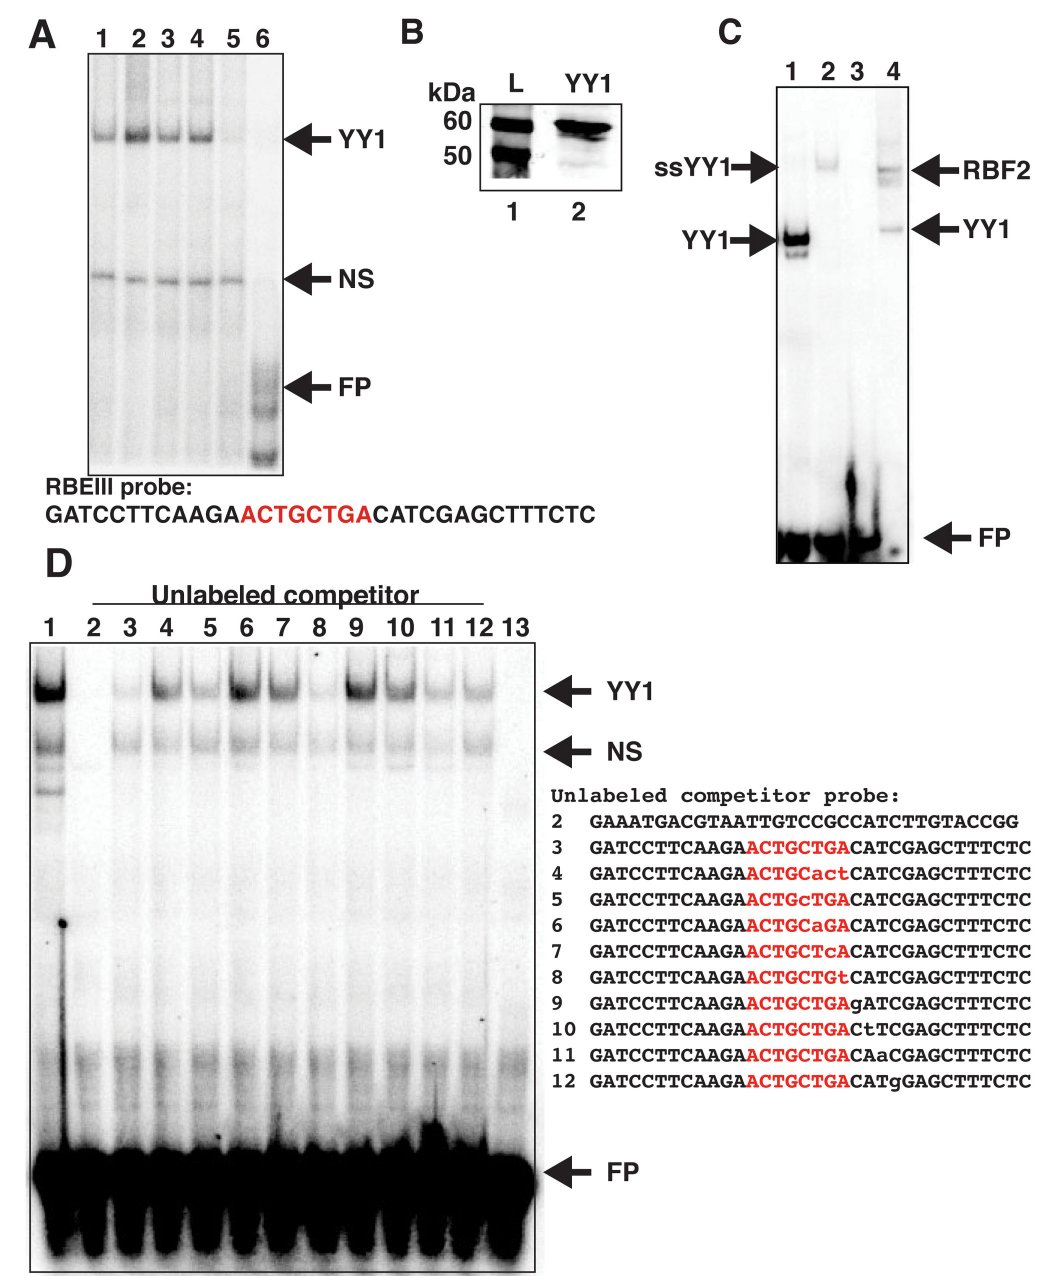
Figure 1. YY1 binds to the HIV-1 LTR near RBEIII. Panel A : EMSA was performed with Jurkat nuclear extracts and radiolabeled RBEIII probe (core RBEIII site highlighted in red). Antibodies to TFII-I (lane 2), USF1 (lane 3), USF2 (lane 4), or YY1 (lane 5) were added to analyze the complex components. Free probe (FP) is shown in lane 6. Panel B : An extract from SF9 cells infected with a baculovirus expressing YY1 was separated on 12% SDS-PAGE and analyzed by immunoblotting with YY1 antibody (lane 2). Lane 1 contains a high molecular weight protein ladder. Panel C : EMSA was performed with recombinant YY1 produced by baculovirus (lanes 1 and 2) or Jurkat nuclear extracts (lane 4) with the radiolabeled RBEIII probe. The RBF2 complex in lane 4 is shown. YY1 antibody was added to the reaction in lane 2. Free probe is shown in lane 3. Panel D : (Top) EMSA was performed with recombinant YY1 and labeled RBEIII probe (lane 1), unlabeled competitor oligonucleotides were added to the reactions at 100-fold molar excess (lanes 2-10) (Bottom). Sequences of unlabeled competitor probes; 2, a known YY1 binding sequence oligonucleotide from the parvovirus promoter; 3, wild type RBEIII probe; 4-5, three nucleotide substitutions; 6-12, point substitutions of the RBEIII probe; 13 free probe (FP). Non-specific (NS) bands are also shown. Substitutions are indicated in lower case. doi: 10.1371/journal.pone.0077052.g001 PLOS ONE |